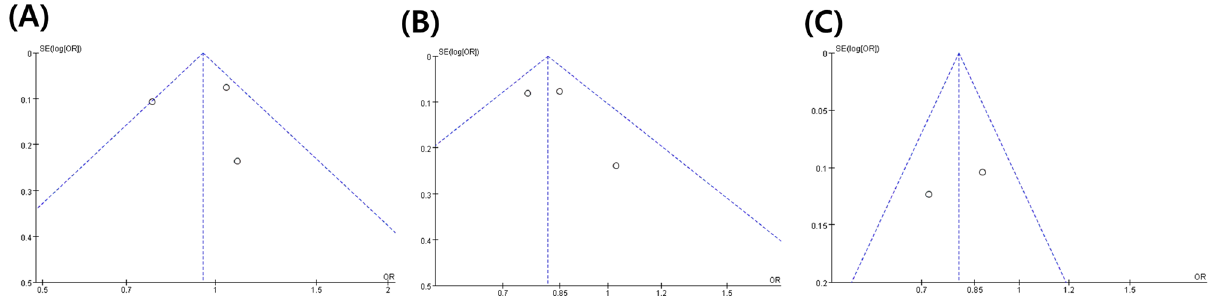
Figure 3. Graphic funnel plot of included studies. Aspirin ( A ), NA-NSAIDs ( B ), and acetaminophen ( C